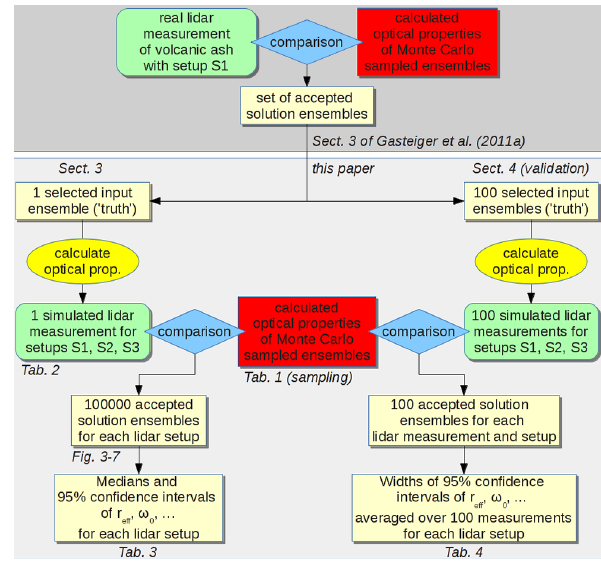
Figure 2. Investigation steps and their products in the current